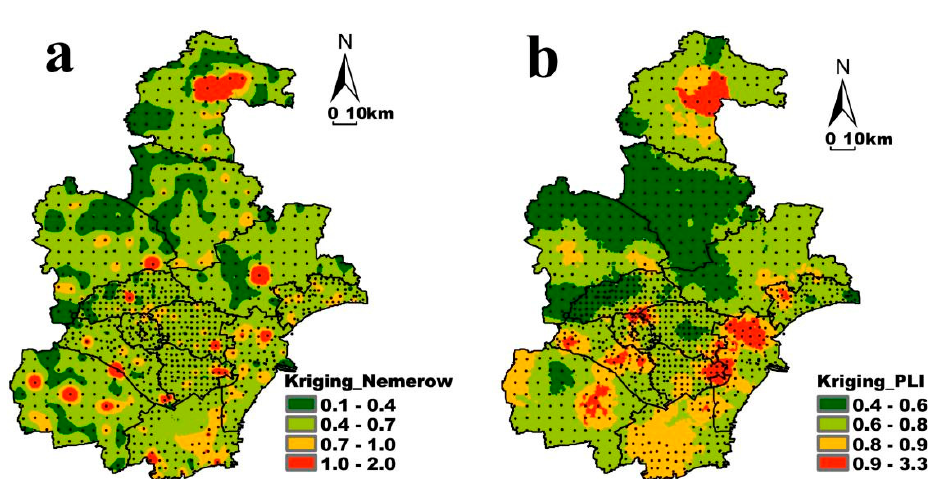
Figure 3. Nemerow comprehensive evaluation index ( a ) and Pollution load index ( b ) of heavy metals in soil .